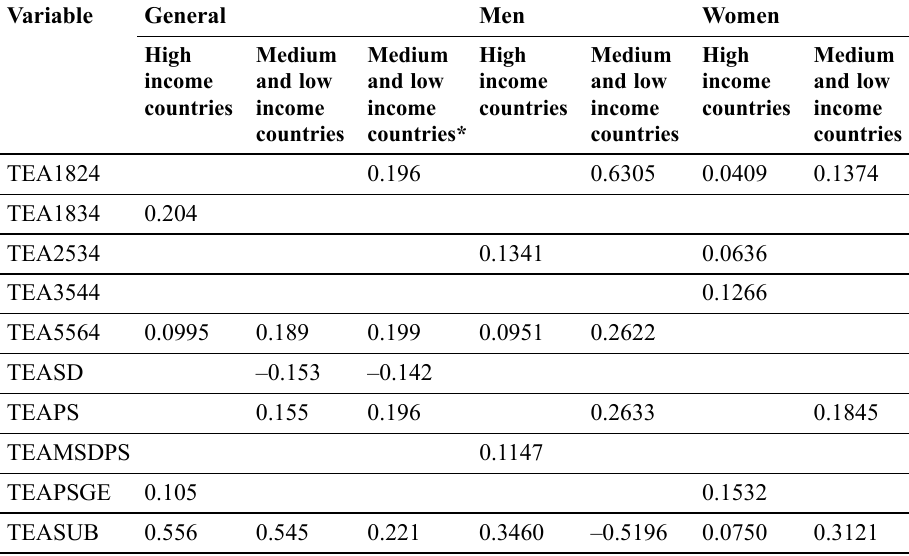
Table 6. Average variable elasticities by country income level: 2002–2006